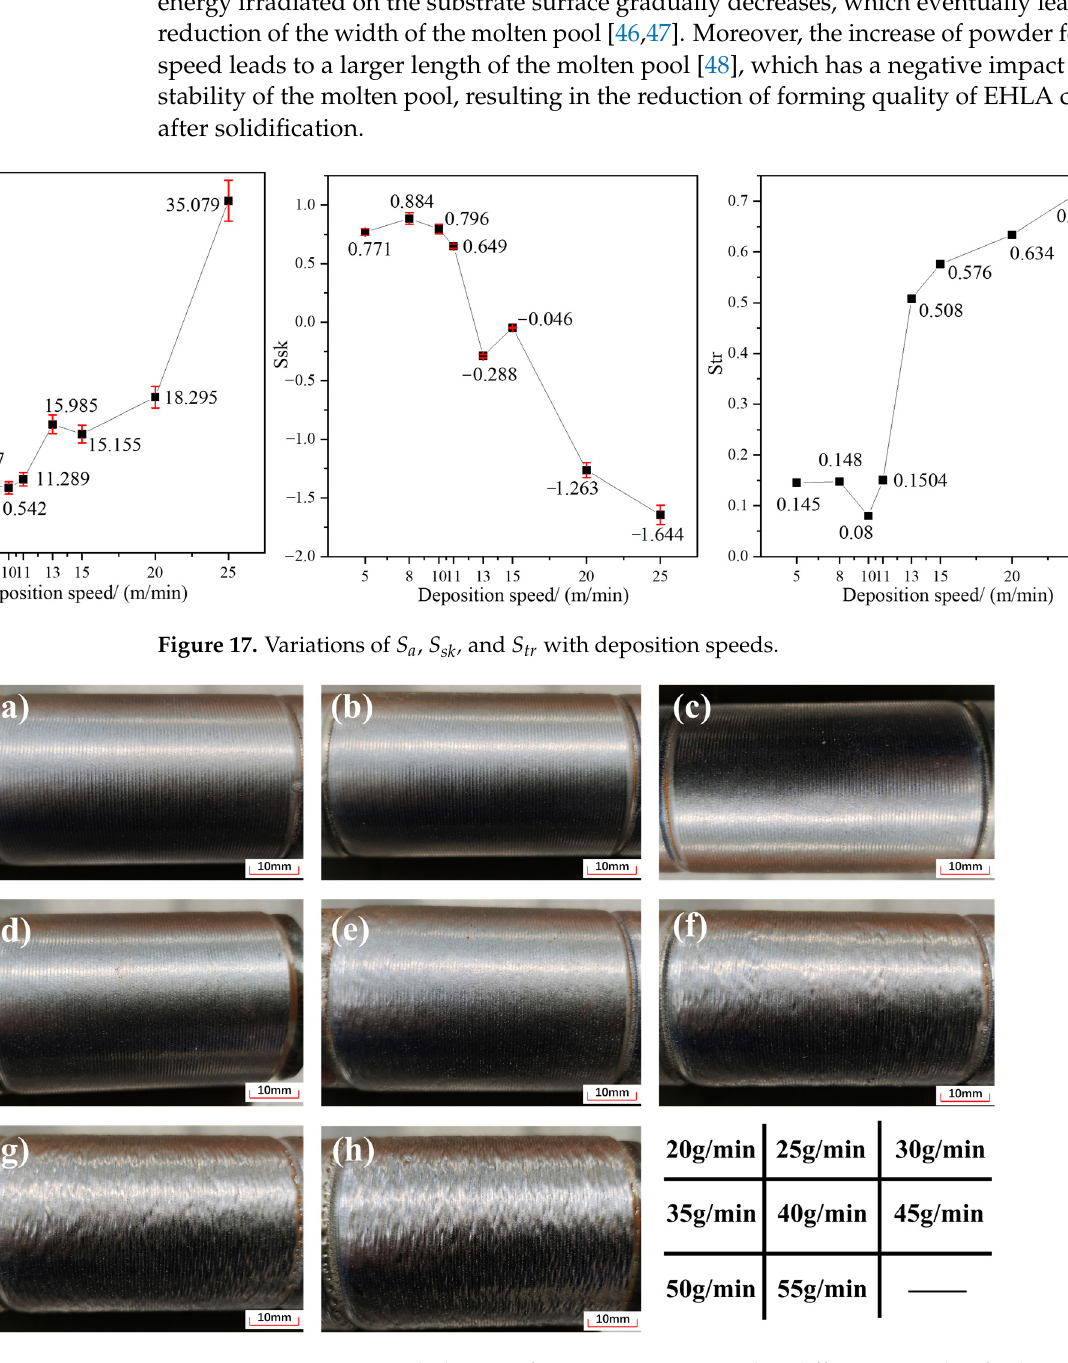
Figure 19. Variations of S a , S sk , and S tr with powder feeding speeds. 4.2.4. In fl uence of Overlapping Ratio During the EHLA process, the liquid melt produced by powder melting is subjected to surface tension and gravity. Moreover, surface tension tends to shrink the liquid melt into a sphere to obtain a minimum surface area and hinder the liquid spreading. Gravity reduces the height of the gravity center of the liquid melt and tends to spread the melt [49]. Finally, the combined e ff ects of the two forces make the surface morphology of sin- gle-pass coating show the characteristics of a high center and a low edge. As a result, when the overlapping ratio was low, the next cladding layer could not fi ll the concave area of the edge of the previous cladding layer, and fi nally formed a groove in the overlapping area (Figure 20a–d). With the increase of overlapping ratio, the distance between two ad- jacent cladding layers decreased gradually, and the next cladding layer could fi ll the con- cave area on the edge of previous cladding layer, which signi fi cantly improved the fl at- ness of the cladding layer (Figure 20e–g). However, when the overlapping ratio was